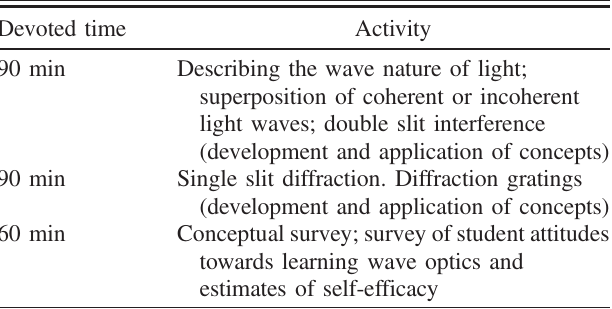
TABLE II. Number of teaching hours devoted to research or teaching